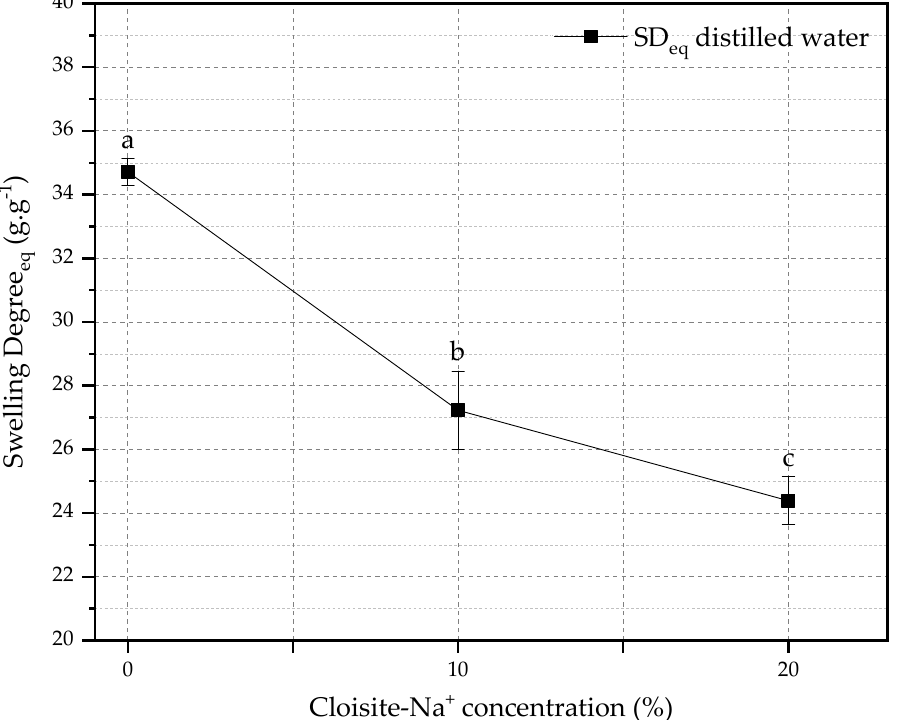
Figure 2. Effect of the amount of Cloisite-Na + on the equilibrium swelling degree. Average with their respective standard deviation values, followed by equal letters do not differ statistically from each other following the Tukey test with a 95% confidence level.